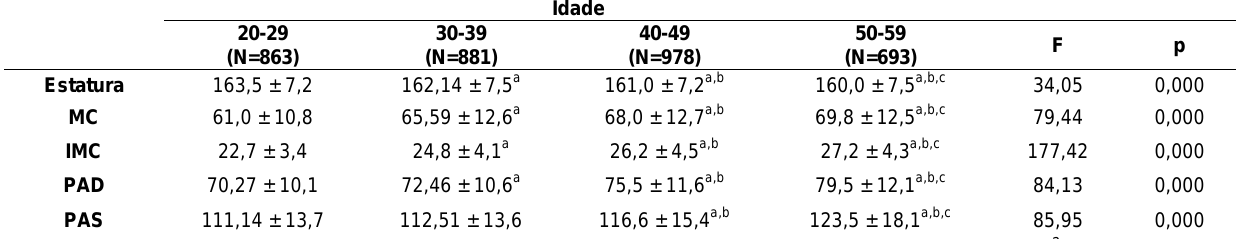
Tabela 2. Caracterização amostral das mulheres, com valores de média e desvio padrão, conforme as categorias de